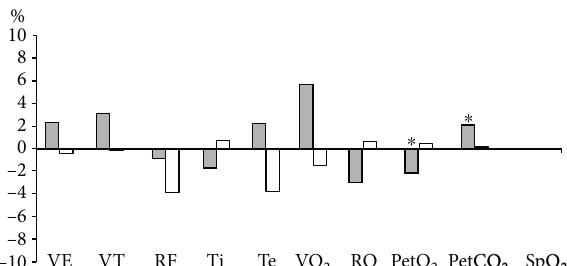
Figure 2: Changes of lung ventilation and gas exchange parameters during the increase of autonomic movement (gray strip) and stimulation (white